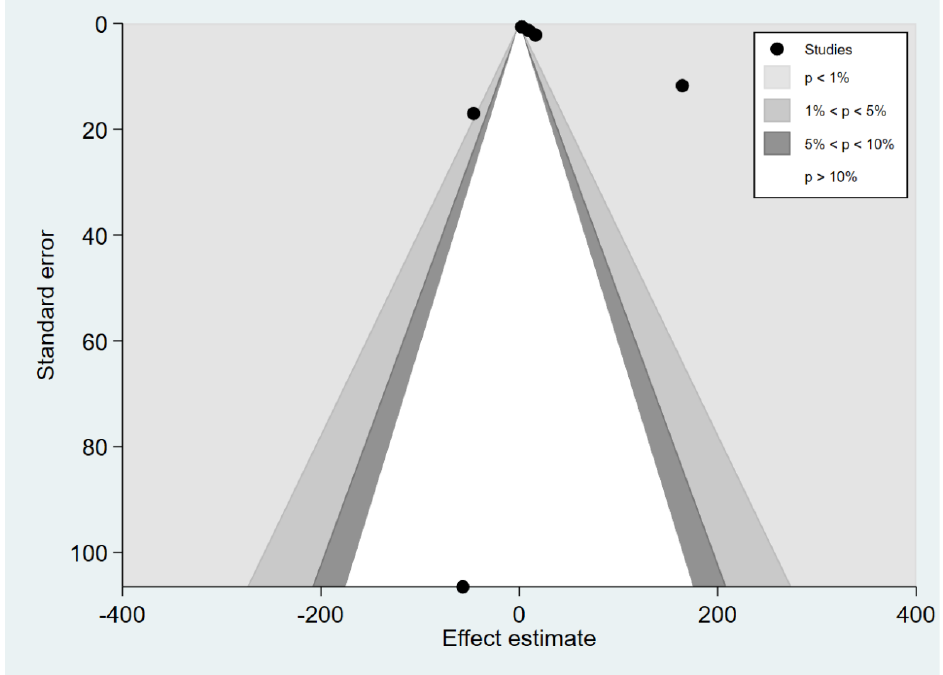
Figure 13. Contour - enhanced funnel plot demonstrated the distribution of the mean difference of IL - 12 levels between uncomplicated malaria and healthy controls from each study . In addition, the funnel plots showed the distribution of the mean differences and the standard error ( se ) of the mean differences in both significant and non - significant areas .